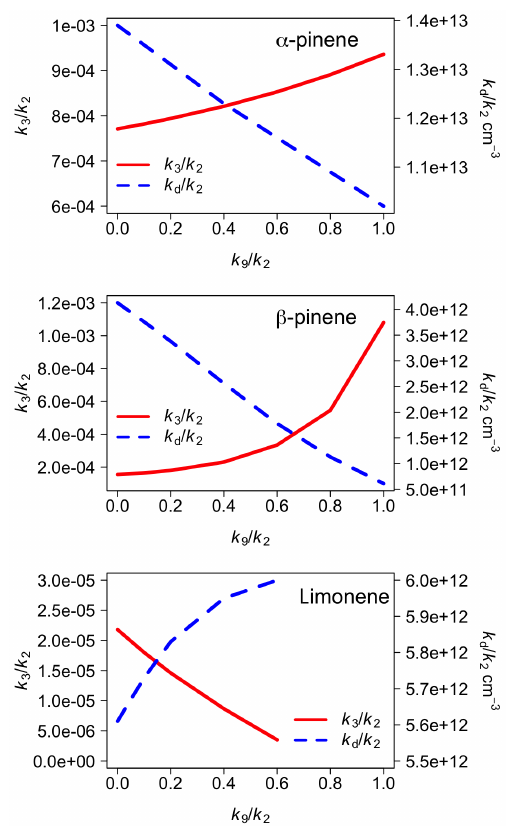
Figure 6. Variation of k 3 /k 2 ( k (SCI-A + H 2 O)) / ( k (SCI-A + SO 2 ) and k d ( k (SCI-B unimol.)) / ( k (SCI-B + SO 2 ) as a function of the ratio k 5 /k 2 ( k (SCI + acid) /k (SCI + SO 2 )) , derived from least squares fit of Eq. (4) to measurements shown in Figs. 3–5 for α - pinene, β -pinene and limonene